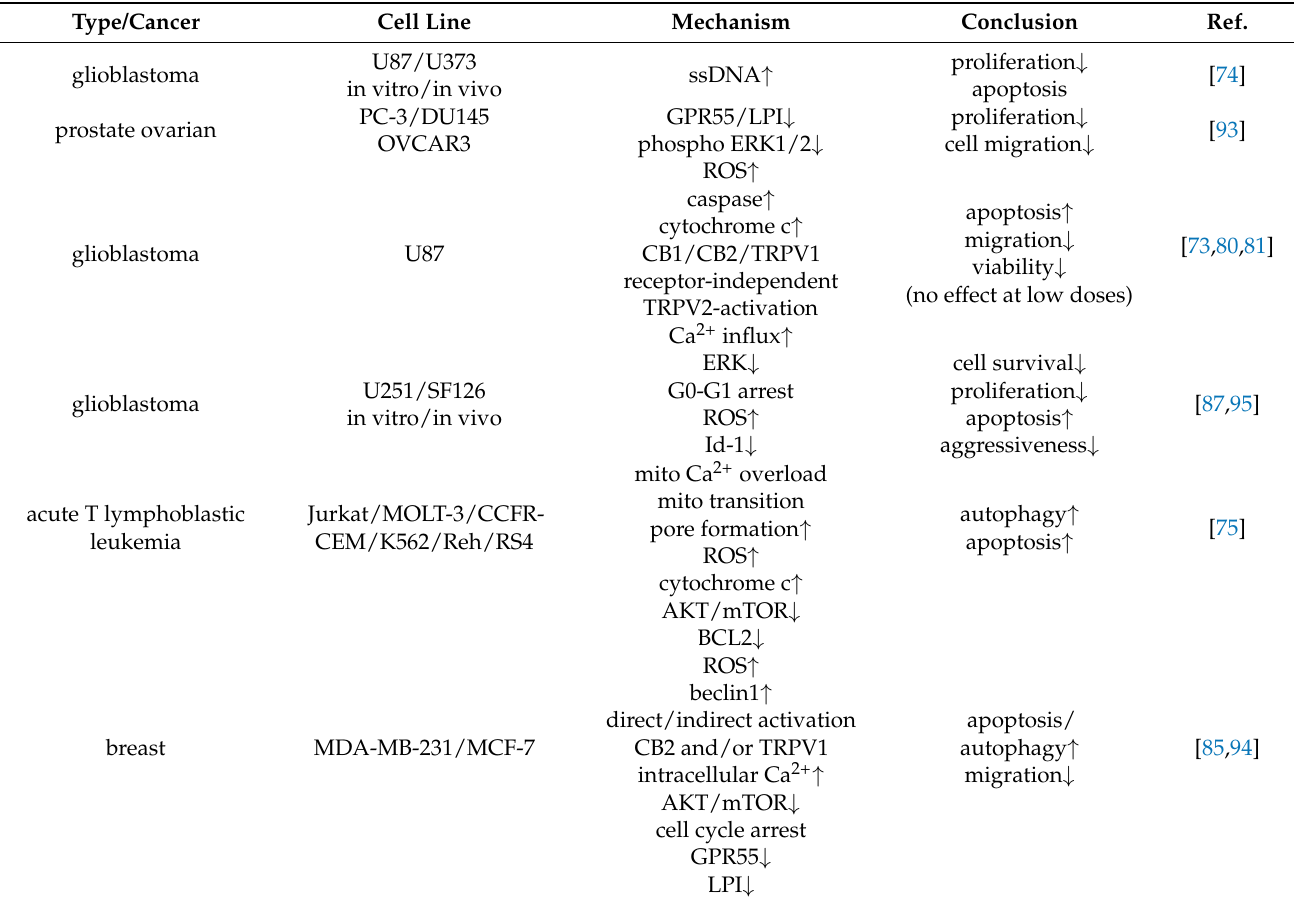
Table 2. Studies summarizing the multiple effects of CBD. Cell Line Mechanism Conclusion